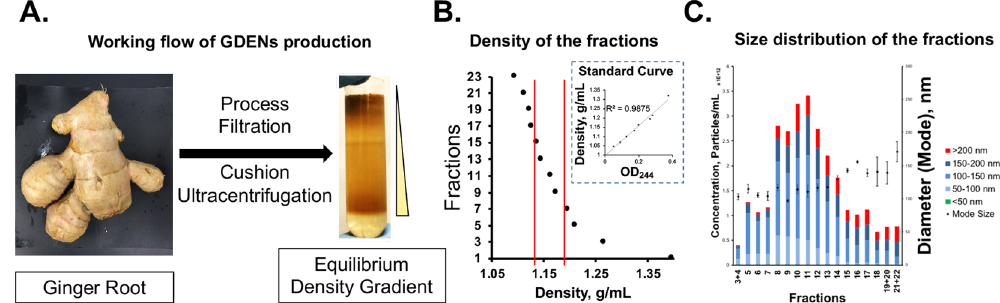
Figure 1. Purification and characterization of GDENs. ( A ) Working flow of purify GDENs from ginger root. ( B ) Density assessment of each fraction collected from equilibrium density gradient measured by OD244 and converted by standard curve (Fig. S1). Density of fraction 8~15 are located within the range of 1.13~1.19 g/mL (indicated by two red lines). ( C ) Size distribution and particle concentration of each fraction measured by NTA and plot with the mode size, original NTA result shown in Fig. S2. DLS characterization of final GDENs product are available in Fig.